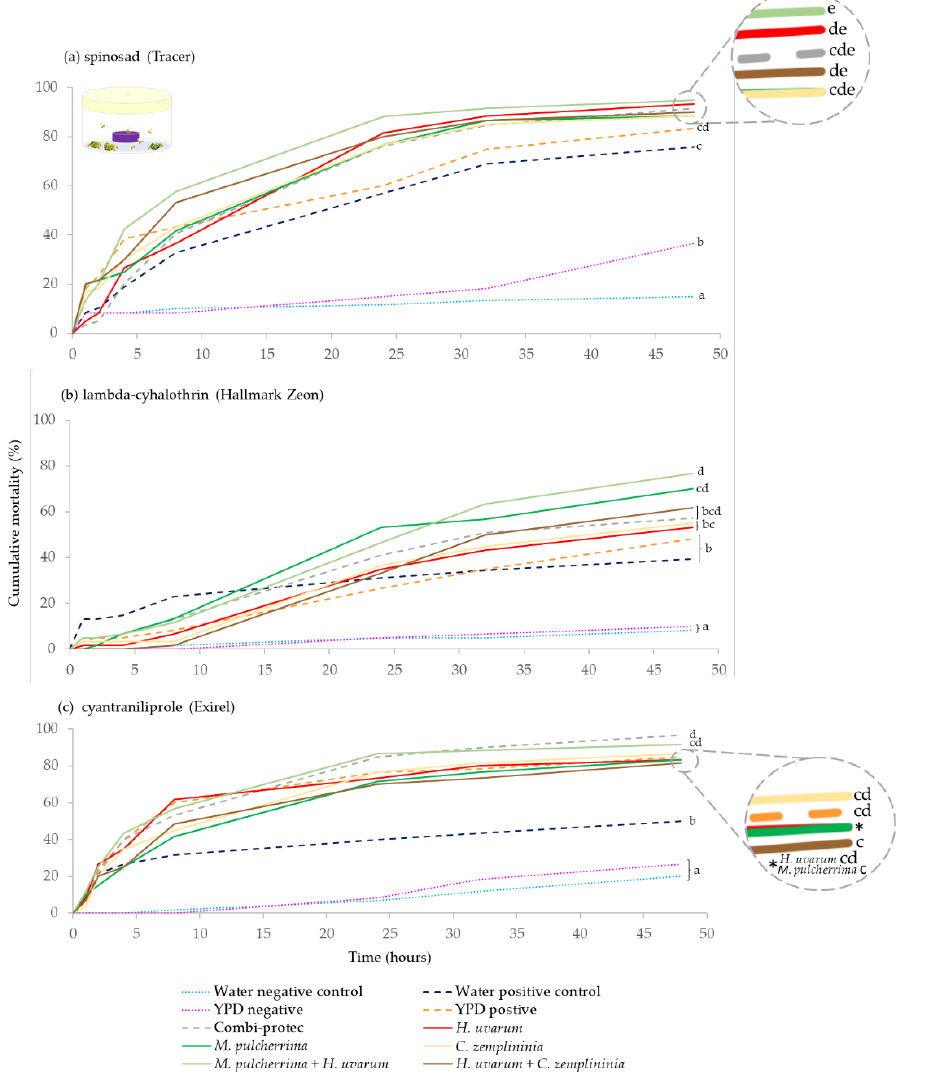
Figure 1. Cumulative percentage mortality of summer-morph D. suzukii exposed to yeast phagostimulant baits ( H. uvarum , M. pulcherrima , C. zemplininia , M. pulcherrima + H. uvarum and H. uvarum + C. zemplininia ) in combination with insecticides ( a ) spinosad, ( b ) lambda-cyhalothrin or ( c ) cyantraniliprole compared to Combi-protec, YPD media and water positive controls (dashed lines) and YPD and water negative controls (dotted lines). Experiments lasted 48 h, and the conditions inside the jars were 22.4 °C and 92.7% humidity with 16:8h light: dark photoperiod. Separate log-Rank Pairwise comparisons for each insecticide were used to determine significance between treatment and different letters at the ends for lines denote significance differences (within each insecticide, p < 0.05).